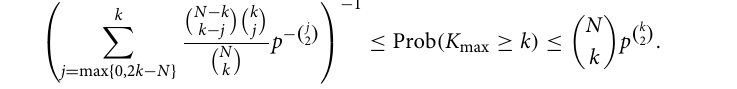
1 . The steps described occur at N 1239 + =